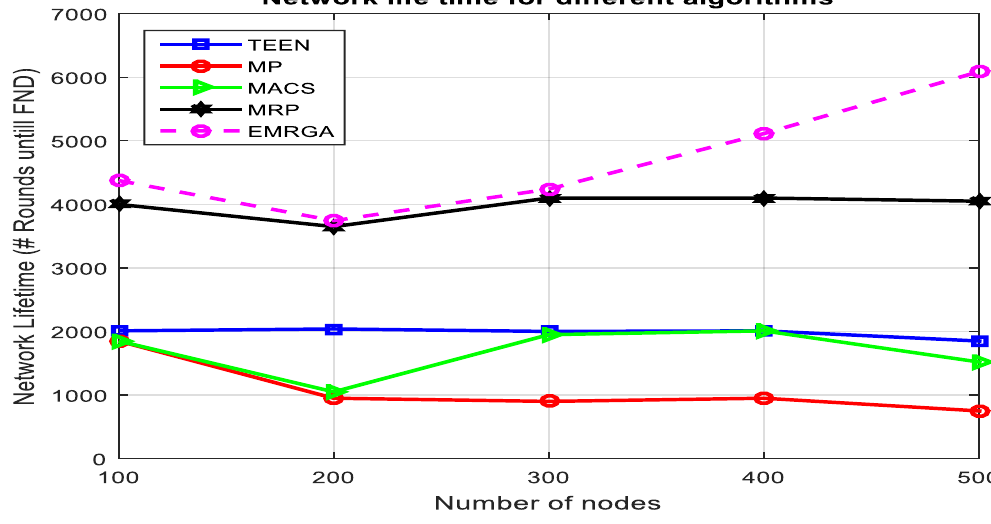
Figure 8. Network Figure 8. Network lifetime.